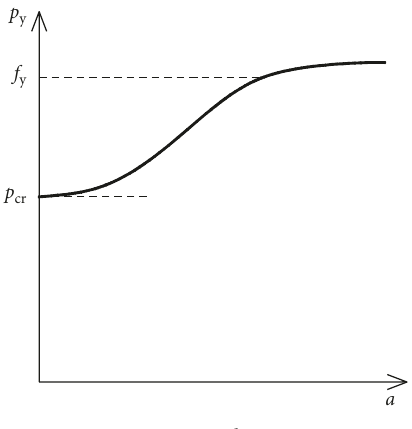
Figure 12: p y - a relation curve.